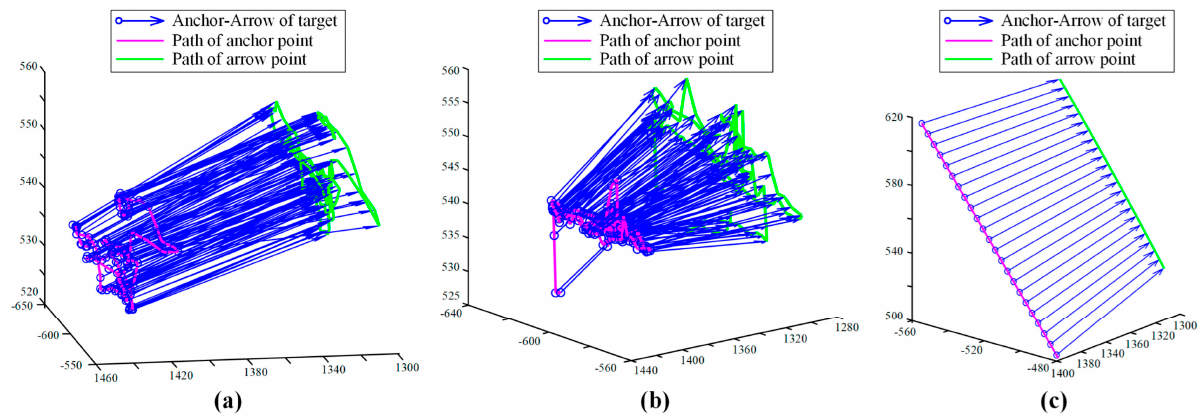
Figure 22. Visualization of the dynamic disturbance motion of the target, also how the oral model is shaken: ( a ) The group of experiment with manual operation and dynamic target. ( b ) The group of experiment with automatic operation and dynamic target. ( c ) The group of simulation with manual operation and dynamic target. Table 2. Average positioning error of different